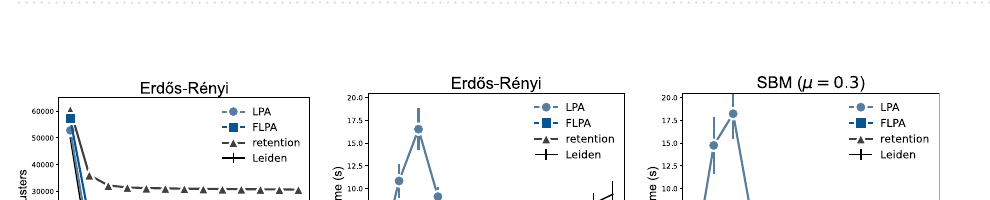
Figure 2. (left) Largest cluster size for Erdőős-Rényi random graphs and (right) the number of clusters for stochastic block model graphs with increasing number of nodes n and the average degree � k � = 10 . Note that the results for LPA are not well visible because they overlap with the results of FLPA.